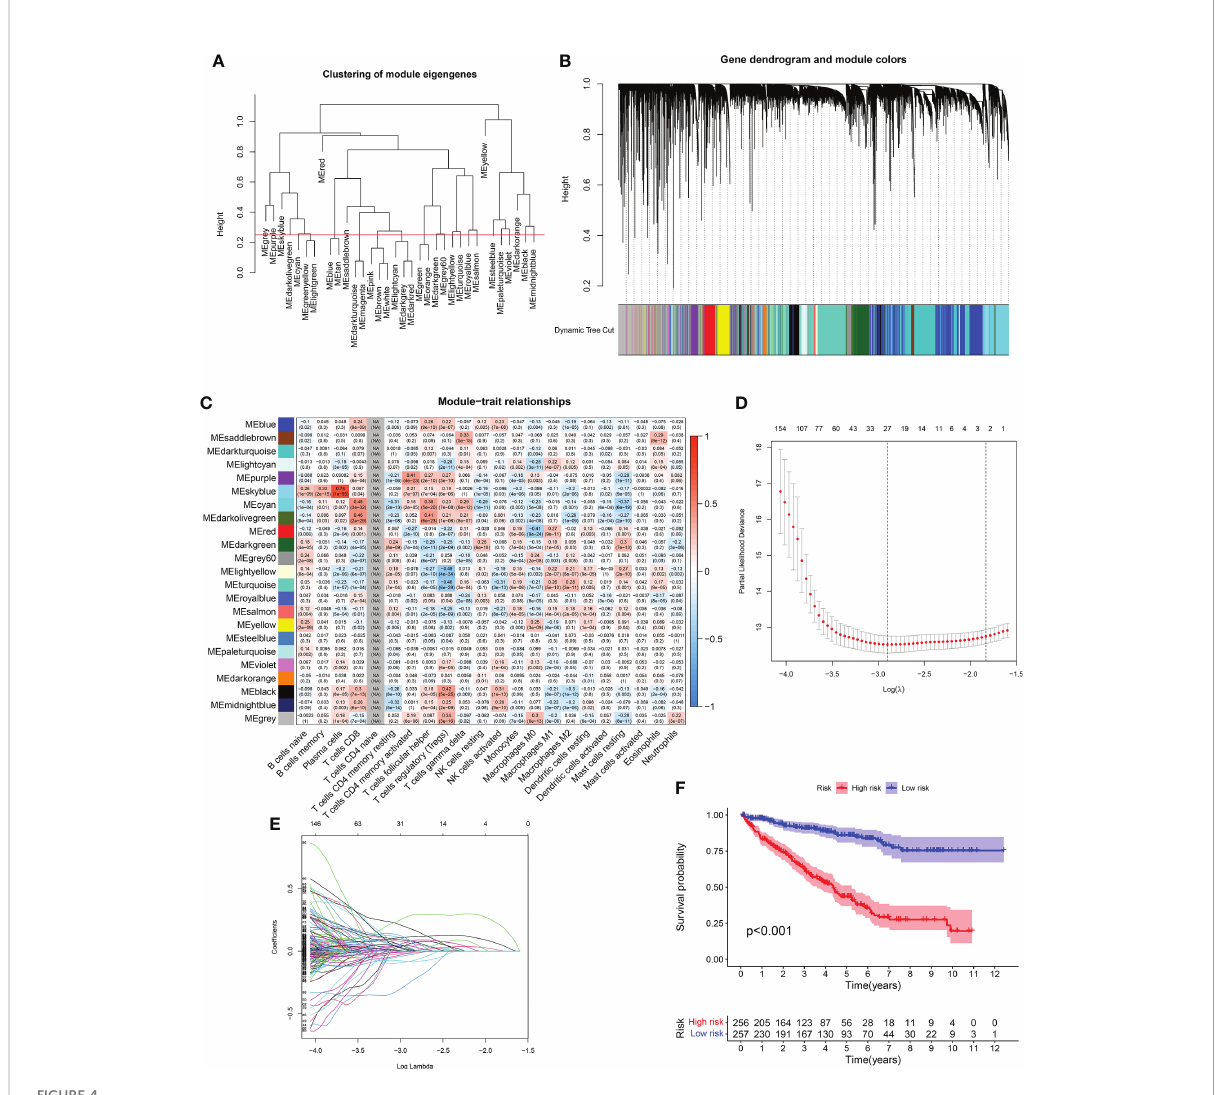
FIGURE 4 (A, B) WGCNA analysis of RCC cohort based on immune-related gene coexpression networks. (C) A total of 23 gene modules were identi fi ed based on WGCNA analysis of RCC cohort. (D, E) The LASSO regression analysis demonstrated that 27 immune-related genes were closely related to the prognosis of RCC patients. (F) The survival analysis between high- and low-risk